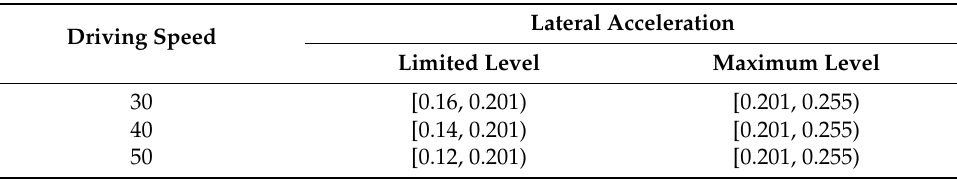
Table 4. Simulation experiment condition parameters.